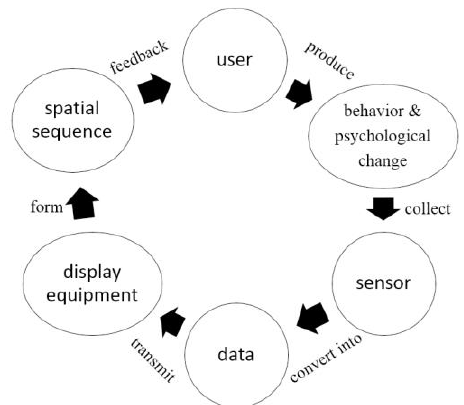
Figure 1. The process of Human-Computer